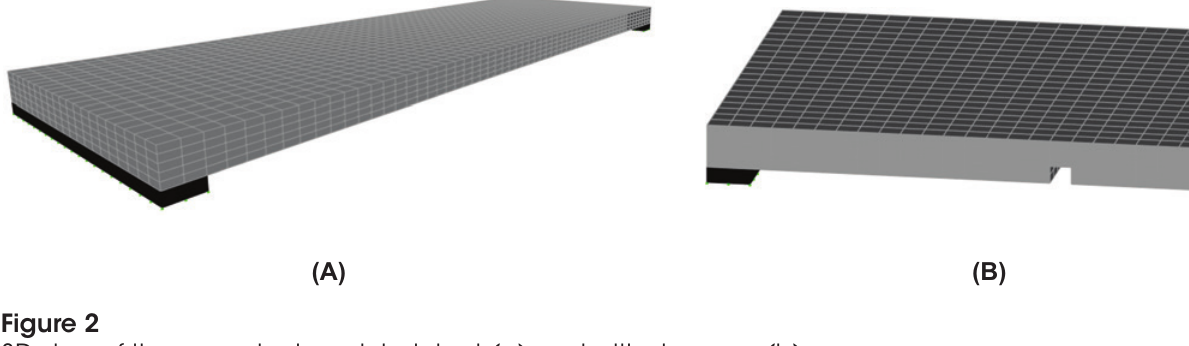
Figure 2 3D view of the numerical model – intact (a) and with damage